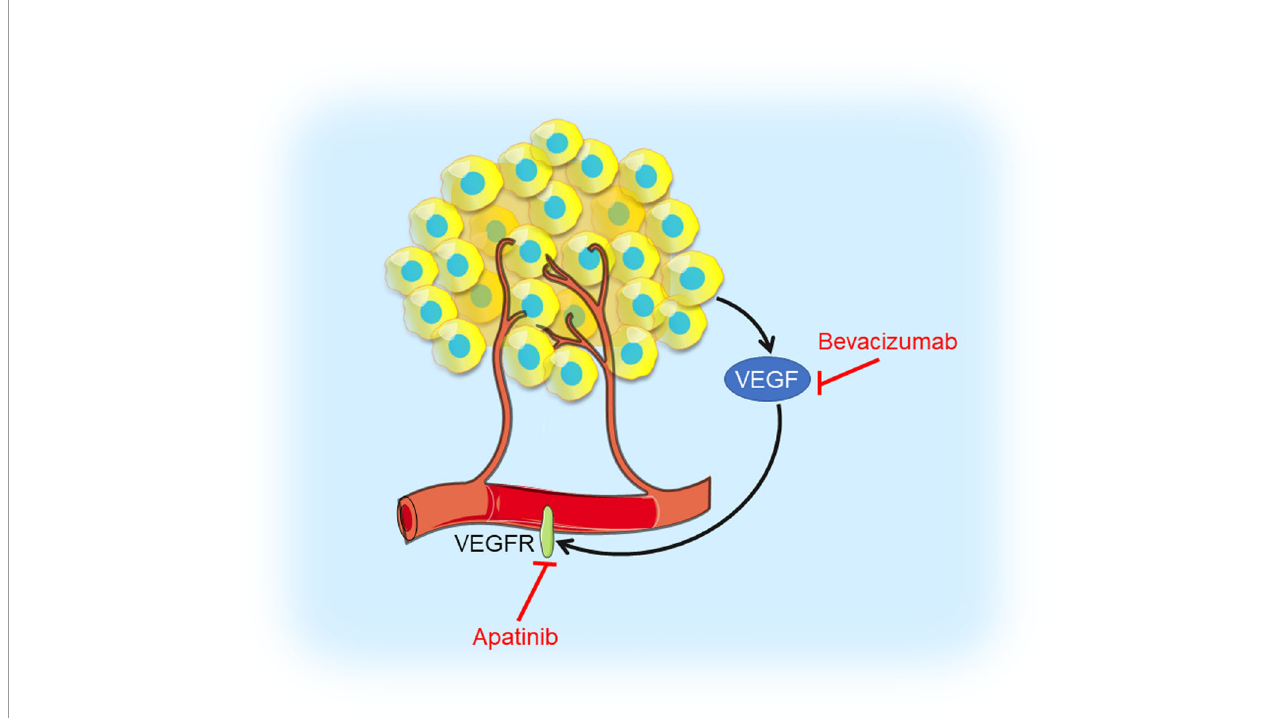
FIGURE 4 | Angiogenesis inhibition in TNBC. Tumor cells produce VEGF which interacts with VEGFR contributing to angiogenesis. VEGF inhibitor bevacizumab and VEGFR inhibitor apatinib could prevent VEGF interacting with VEGFR, thus blocking tumor